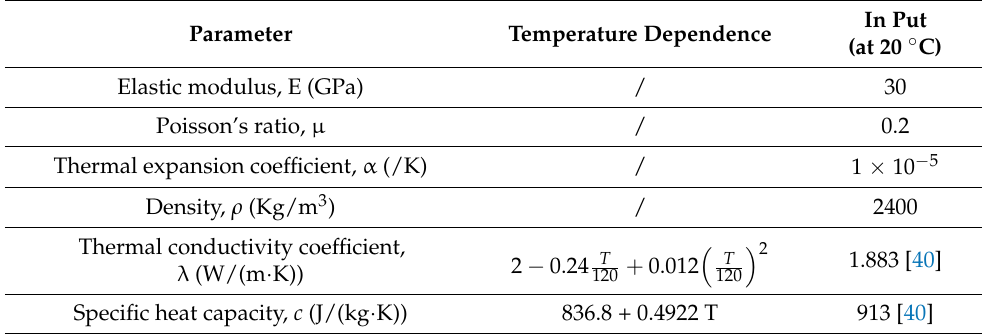
Table 4. Detailed mix proportion design of concrete